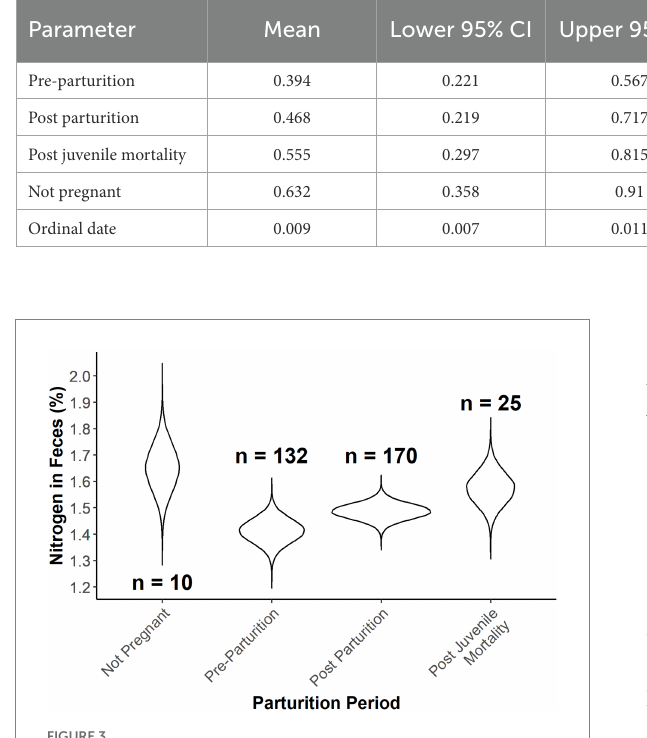
FIGURE 3 Expected fecal nitrogen percent as a function of Ordinal date and provisioning status of female desert bighorn sheep at Lone Mountain, Nevada (2016–2018). Violin plots represent the posterior distributions for the predicted mean values derived from an ANCOVA model of fecal nitrogen modeled as a function of provisioning status at Ordinal date 115, which was fitted in a Bayesian framework ( n =